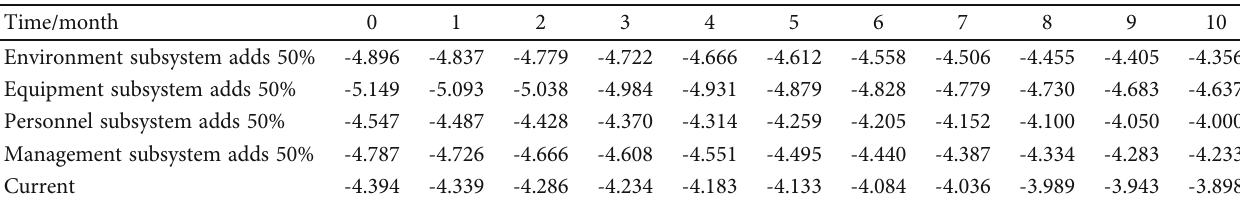
Table 7: simulation results of sensitivity